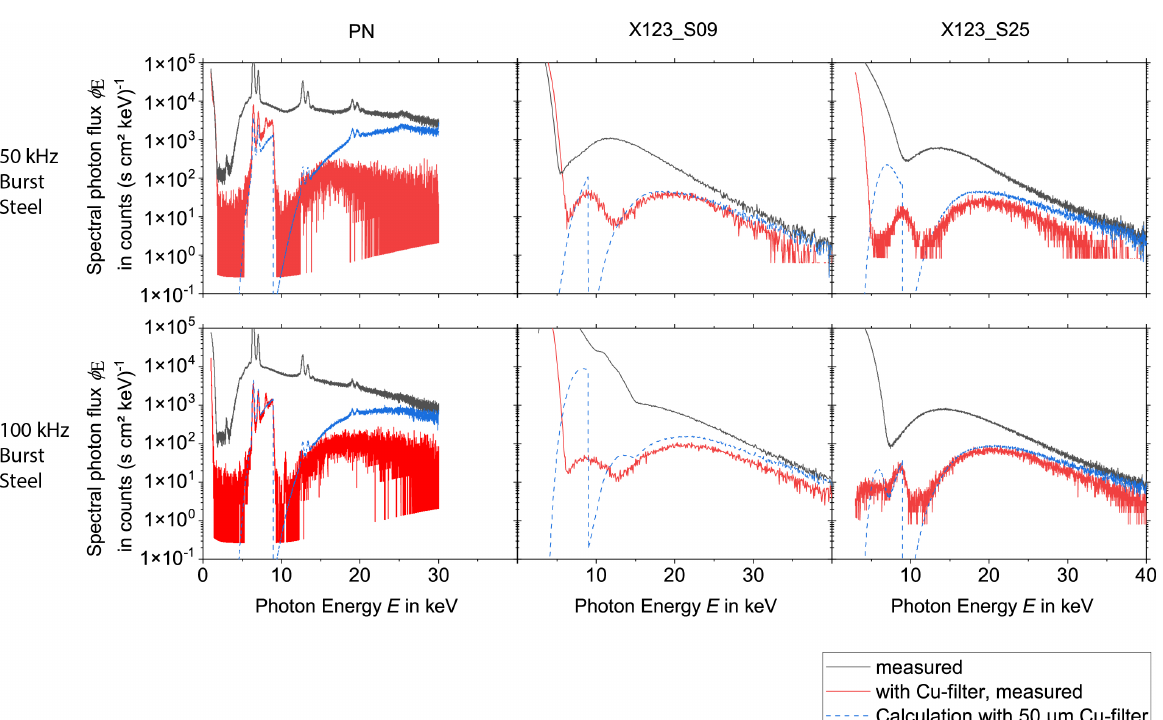
Figure 6. X-ray spectra measured during the laser processing of steel without burst mode for the three spectrometers PN, X123_S09, and X123_S25, the measurement with and without Cu-filter was compared with the calculation with copper filter of 50 μ m thickness. Note the logarithmic scaling of the ordinate axes.